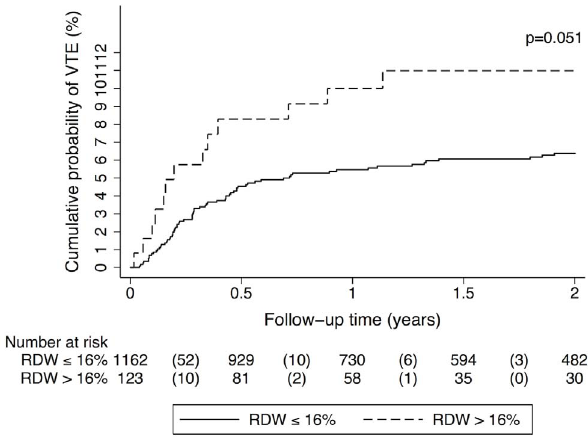
Figure 2. Cumulative incidence of venous thromboembolism (VTE), accounting for competing risk (death of any cause) in patients with solid tumors, grouped into patients with red cell distribution width (RDW) . 16% and below ( # 16%), respective- ly. The probability of VTE was higher in patients with high RDW ( . 16%) compared to patients with lower RDW (Gray’s test p=0.051). Numbers in parentheses indicate numbers of VTE events in the respective group and time period.